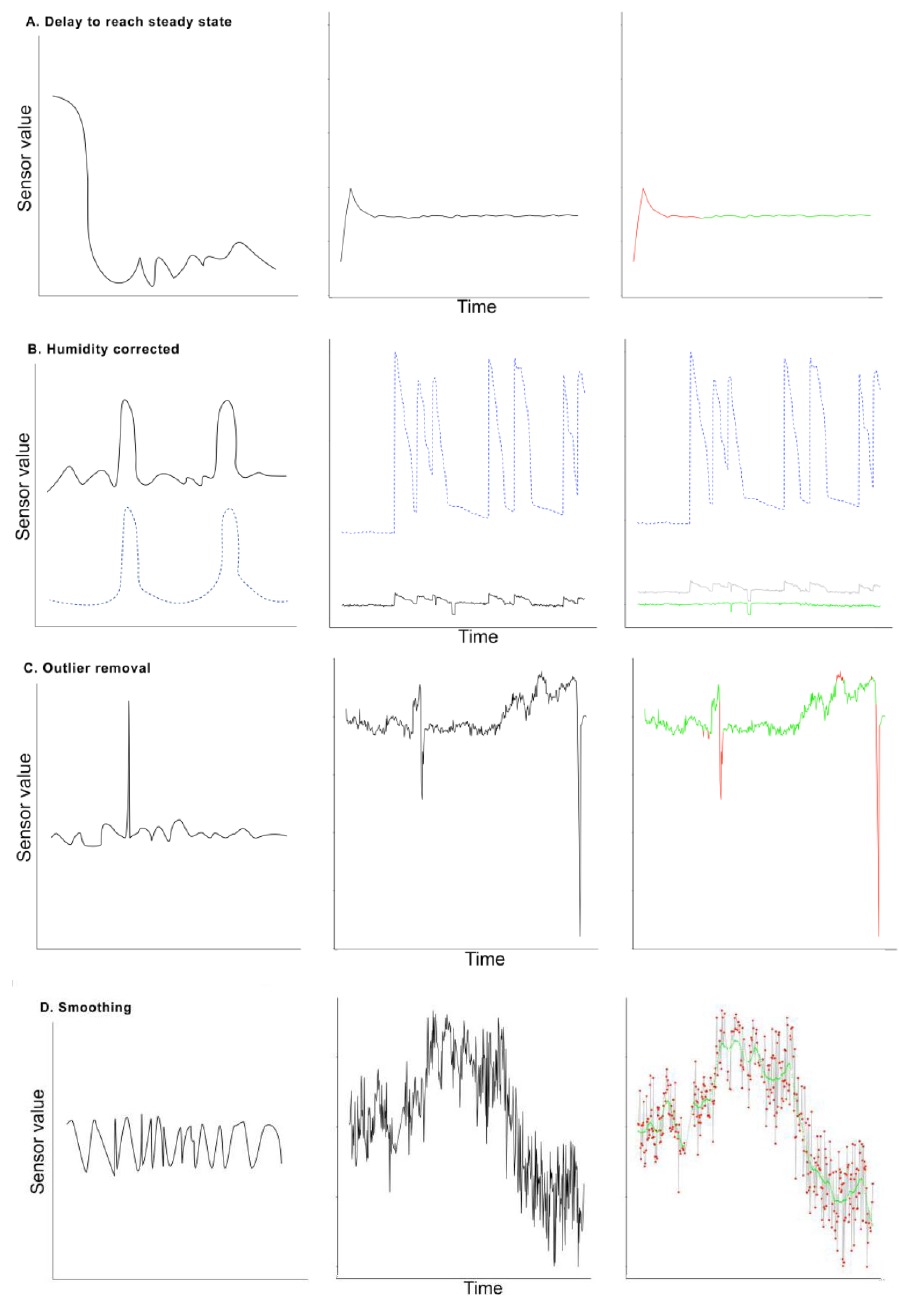
Figure 2. Cont Figure 2. Cont.